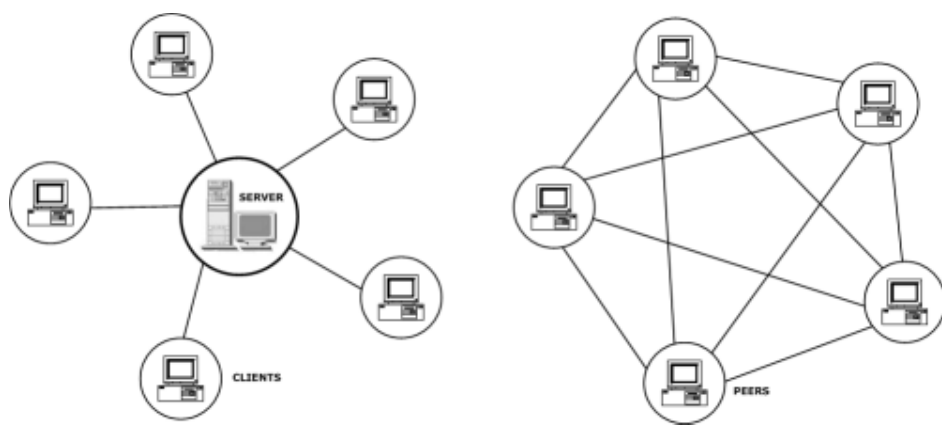
Figure 1 Simplified configuration of P2P and client–server